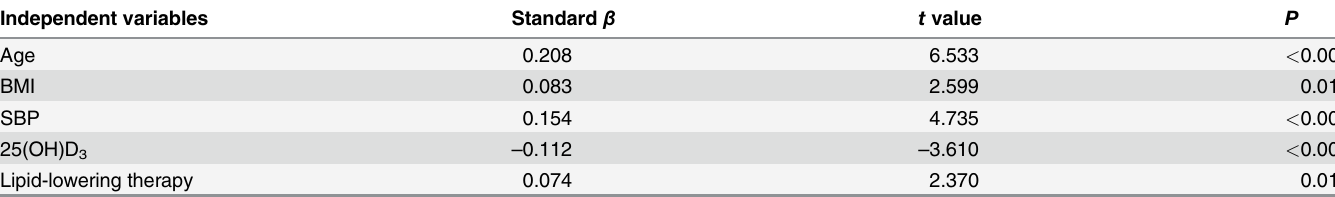
Table 3. Independent factors of increased C-IMT identified by multiple linear regression analysis.